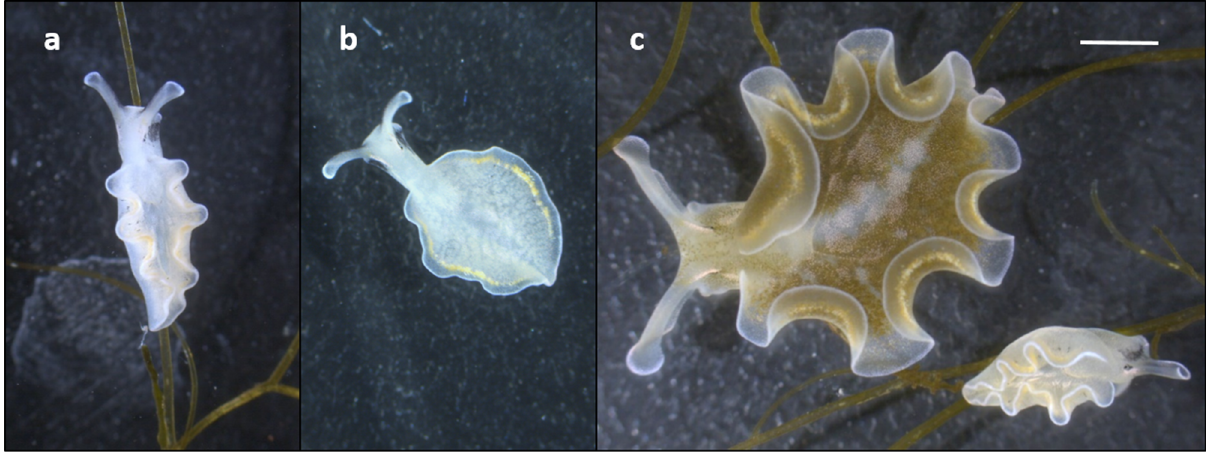
Figure 2. The aposymbiotic juvenile of Elysia crispata ( a , b ). The specimen was unable to retain chloroplasts from its food source, the macroalga Bryopsis plumosa . The “albino” sea slug was significantly smaller than its kleptoplast-bearing siblings ( c ). Chloroplast acquisition is required for the normal development of E. crispata . Scale bar: 2 mm.